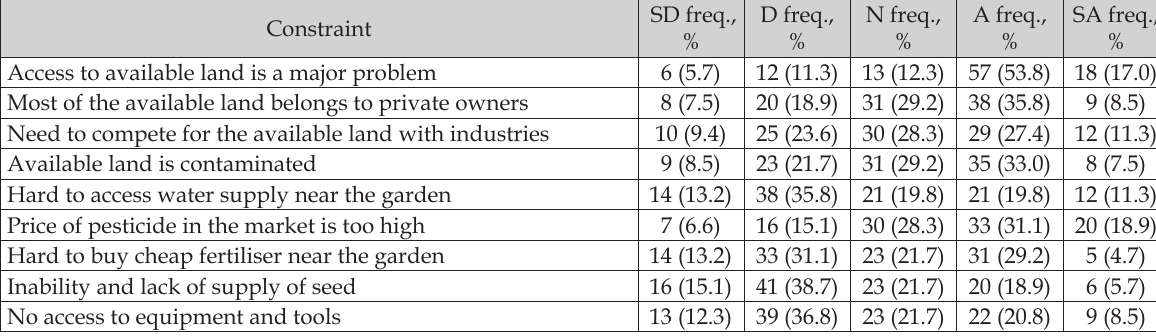
Table 5. Resource-related